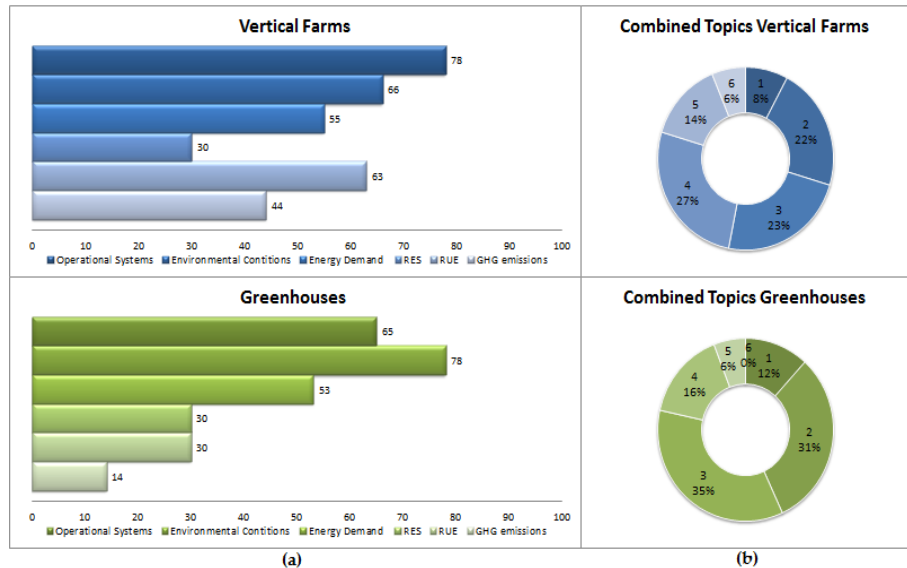
Figure 1. ( a ) Percentage for every topic mentioned in the literature and ( b ) percentage of combined topics for GHs and VFs. topics for GHs and